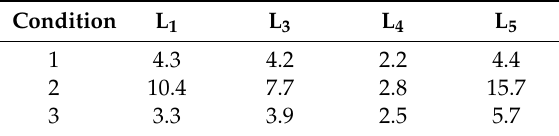
Table 4. Weight % of DPQ in PPE.